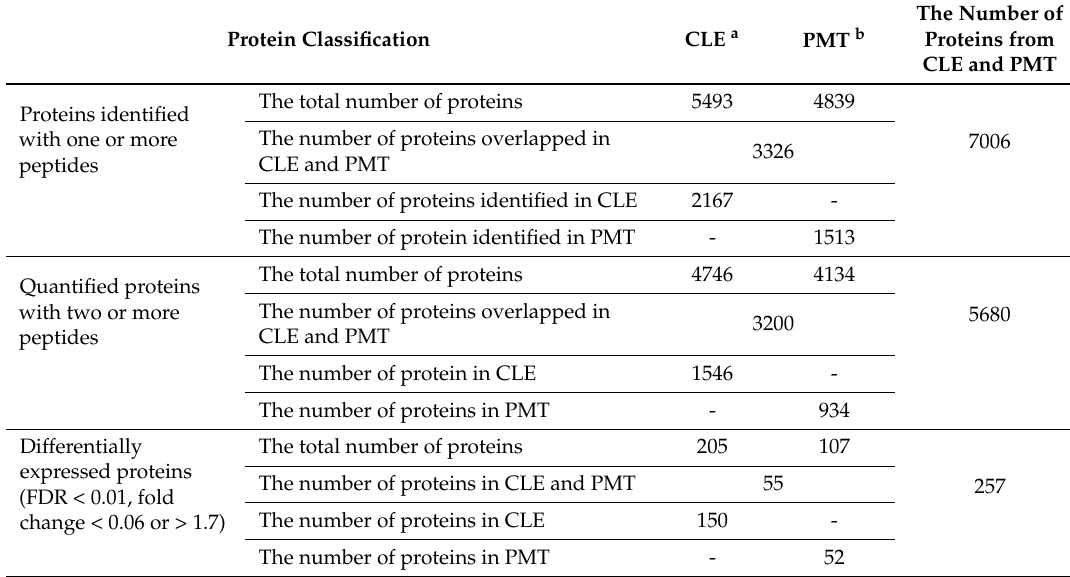
Table 2. The number of proteins identified in the proteomes identified using the crude leaf protein extracts and ProteoMiner-enriched